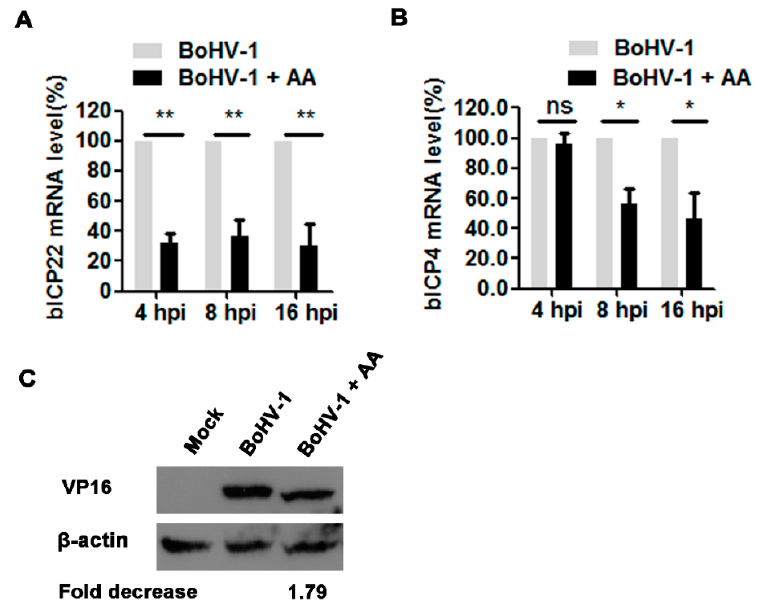
Figure 4. The effects of HAT inhibitor on BoHV-1 gene expression. ( A , B ) The virus infected cells were treated with DMSO or AA (5 µM). Total RNA was prepared at indicated time points, and qRT-PCR was performed to determine the mRNA levels of bICP4 ( A ) and bICP22 ( B ). ( C ) MDBK cells in 60 mm dishes were infected by BoHV-1 at an MOI of 1 with the treatment of DMSO or AA (5 µM), at 16 hpi, cell lysate was prepared and subjected to Western blots to detect VP16 protein. The band intensity was analyzed with software image J. And analysis was compared with that of untreated but infected control. Data represent three independent experiments. Significance was assessed with the student t test (* p < 0.05, ** p < 0.01). ns: not significant.